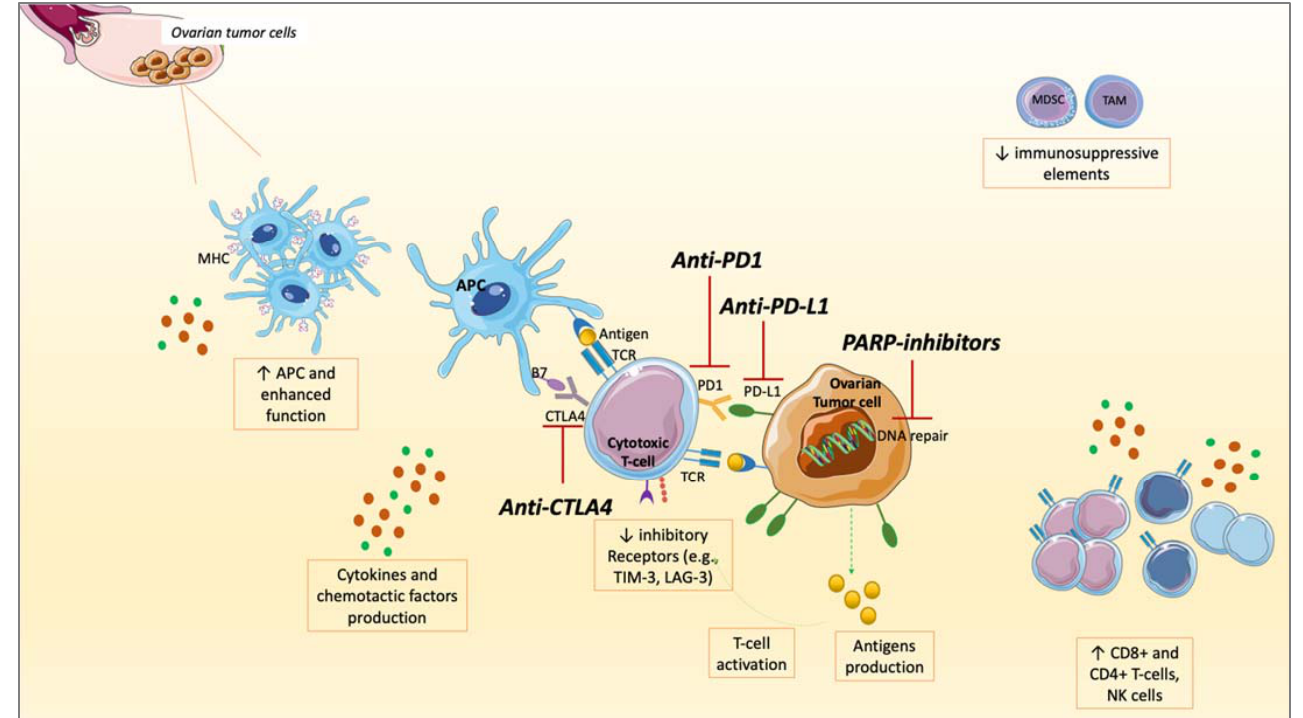
Figure 2. The interplay between PARP inhibitors (PARPis) and immune checkpoint inhibitors (ICIs): modifications of soluble factors and cell of tumor microenvironment (TME) in ovarian cancer (OC). After the administration of PARPis, a series of modifications occur: an increased production and surface exposure of antigens on tumor cells, increased PD-L1 expression, production of cytokines, and chemotactic factors. Antigen-presenting cells (APCs) are enhanced in their function with major histocompatibility complex (MCH) up-regulation and increased in numbers. A higher number of CD4+ and CD8+ T-cells, and NK cells, are recruited at tumor sites, resulting in higher TILs and immune response activation. On the other hand, immune-suppressive elements such as Myeloid- derived suppressor cells (MDCSs) and Tumor-associated macrophages (TAMs) are reduced, as well as inhibitory receptors (such as T-cell membrane protein 3 [TIM-3], Lymphocyte-activation gene 3 [LAG-3]). These modifications shift the TME toward a higher immune responsivity. Targeting